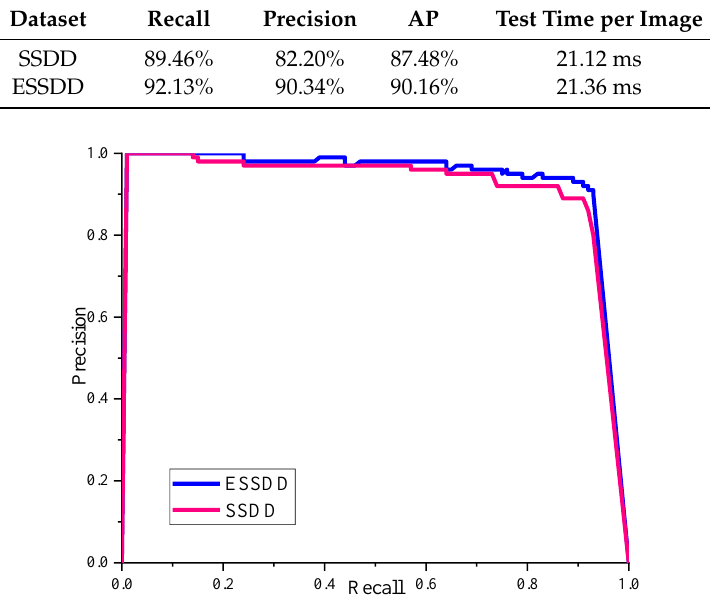
Figure 13. The P-R curve of SSDD and ESSDD. P: precision; R: recall.